Question: Write a single sentence explaining what this figure depicts.
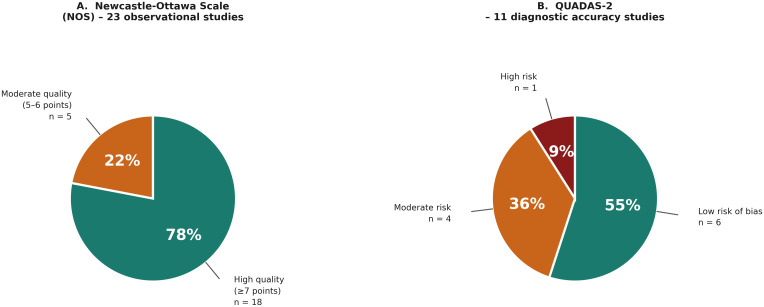
Answer: Summary of study quality assessments. (A) NOS ratings: 78% (n = 18) achieved high quality (>=7 points); 22% (n = 5) were moderate quality (5–6 points). (B) QUADS-2 risk of bias: 55% (n=6) low risk; 36% (n=4) moderate risk; 9% (n=1) high risk.